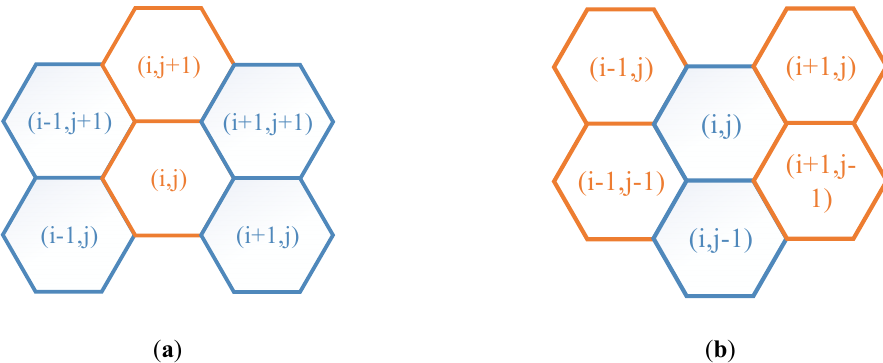
√ 3 l , as shown in Figure 3. 2